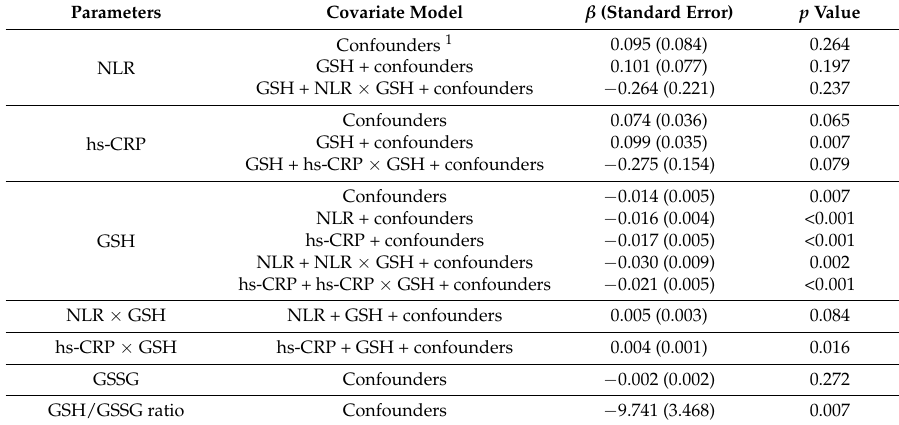
Table 3. Multiple linear regression analysis with Child–Turcotte–Pugh score as the dependent variable in patients with liver cirrhosis after adjusting for potential